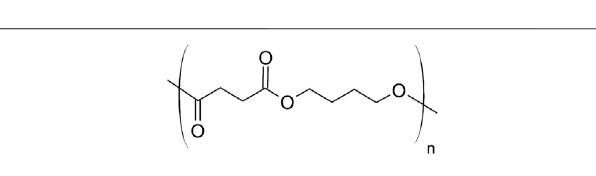
FIGURE 1 | Typical morphology variants of particles composed of two types of polymers. The fi nal morphology of particles synthesized by seeded polymerization using polymer seed (black color denotes polymer (1) swollen with monomer 2 with the formation of polymer 2 (white color) can be shown in (A) (ideal core – shell morphology) or in (B) inverted core-shell structure. Composite particle morphology can be composed of one type of polymer (polymer 2) with embedded domains of polymer 1 (in case of the particle (C) in the whole particle, (D) domains present in the particle shell region), or vice versa. The favorable morphology of particles exhibits the minimum interfacial free energy change. Shell chemical composition may also change gradually, that is, particle ’ s shell is enriched with a latter component going from a particle ’ s core to its surface (in case of (E) ). Redrawn from Gosecka and Gosecki (2015).